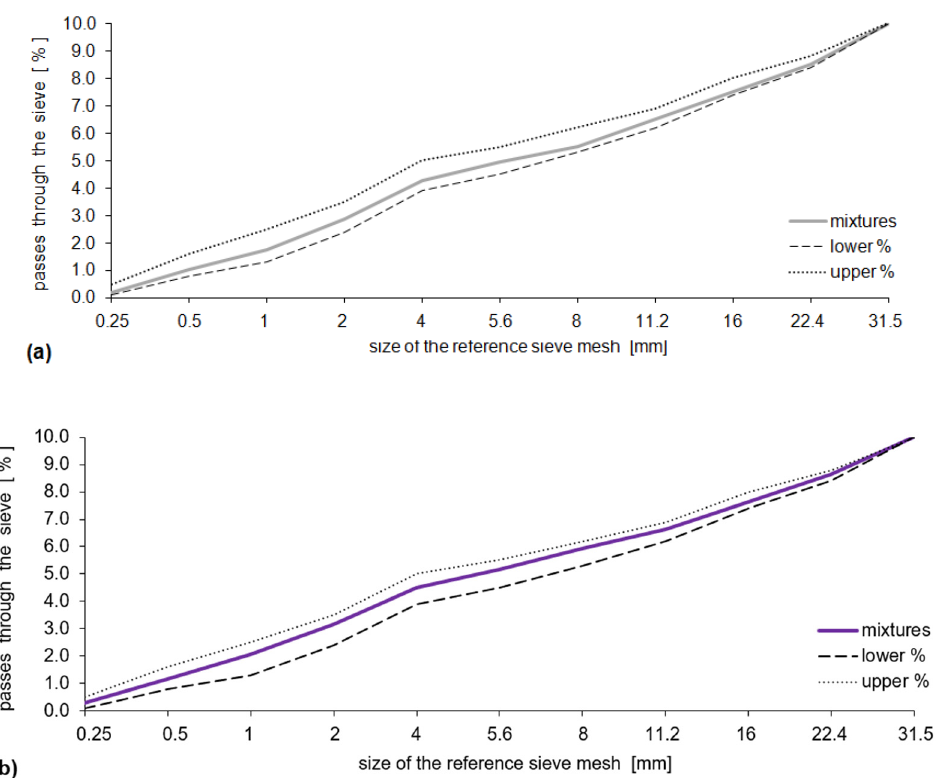
Figure 6. Aggregate compositions of CC-1 ( a ) and CC-2 ( b ) mixes.